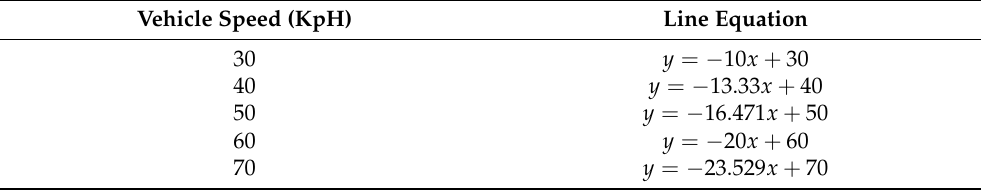
Table 3. Line equation according to vehicle speed and saturation